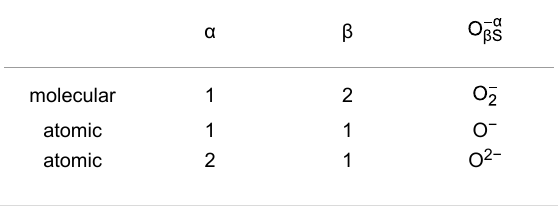
Table 2: Possible combinations of α and β and the resulting chemi- sorbed oxygen